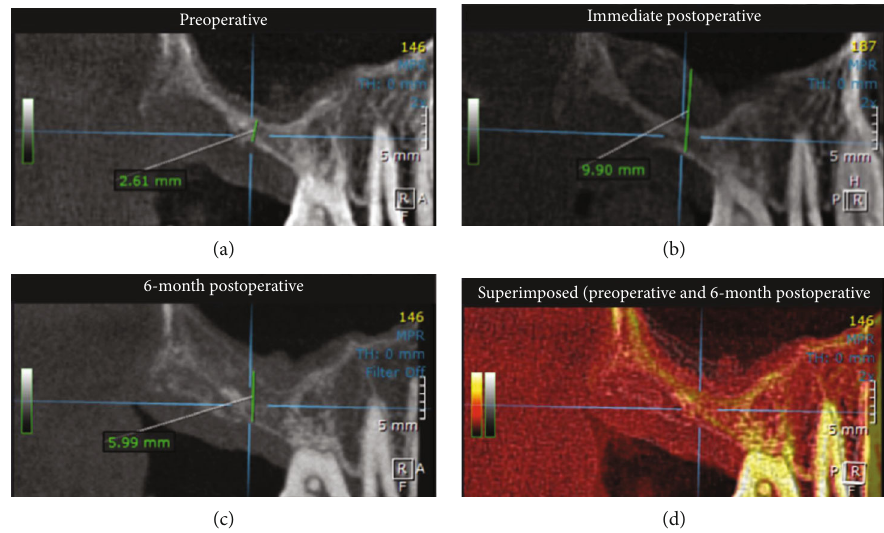
Figure 1: The sagittal view CBCT images show the left posterior edentulous maxillary region of the patient at preoperation (a), immediate postoperation (b), 6-month postoperation (c), and superimposed CBCT image between preoperation and 6-month postoperation of the lateral sinus augmentation